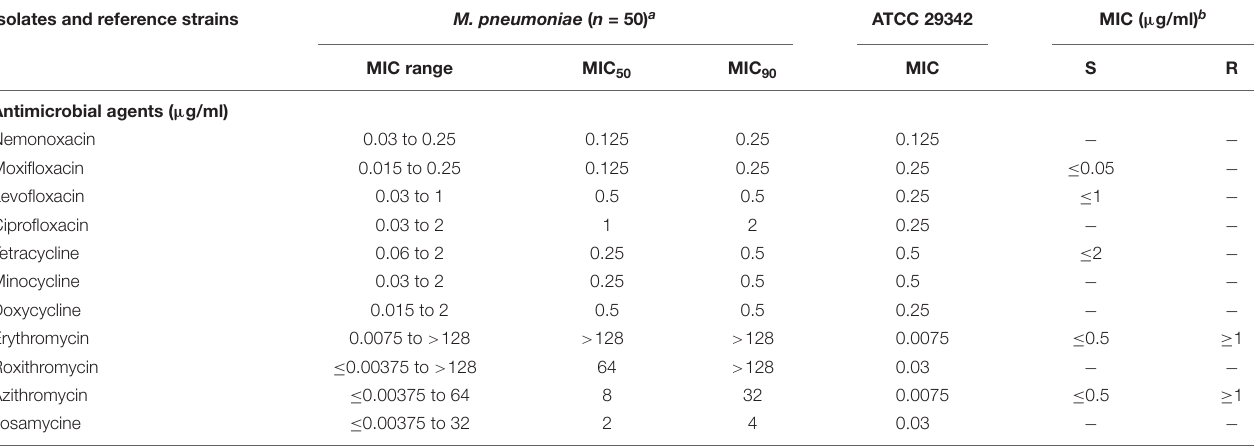
TABLE 1 | Minimal inhibitory concentration summary of nemonoxacin and comparator agents against M. pneumoniae . Isolates and reference strains